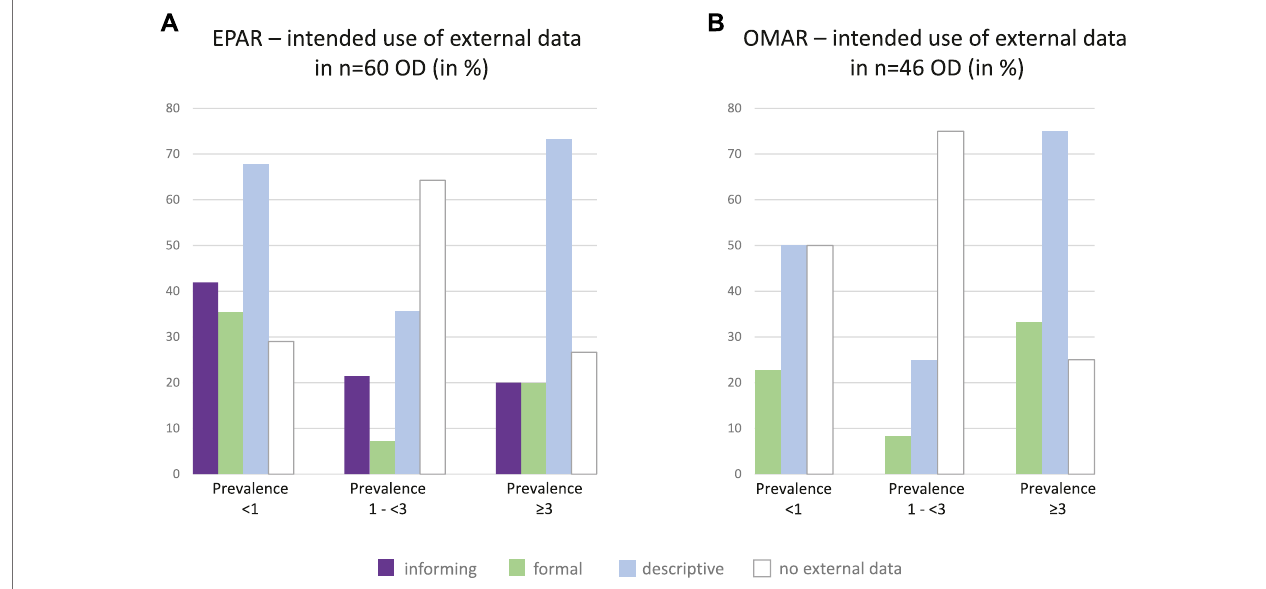
FIGURE 5 | Intended use of external data. Intended use of external data in (A) pre-approval setting, n = 60 ODs (EPARs of all authorized products), and (B) “ signi fi cant bene fi t ” justi fi cation, n = 46 ODs (OMARs of all authorized products which needed to comply with the “ signi fi cant bene fi t ” criterion) were categorized and analyzed according to prevalence groups. No informing use was observed in the OMARs. EPAR: European public assessment report; OD: orphan designation; OMAR: Orphan maintenance assessment